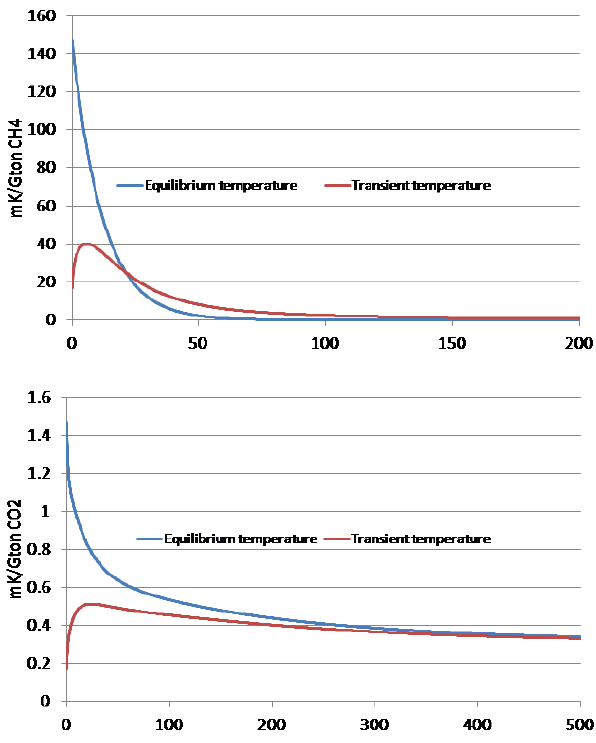
Fig. 4. Equilibrium and transient temperature response for a pulse emission of CH 4 (upper panel) and CO 2 (lower